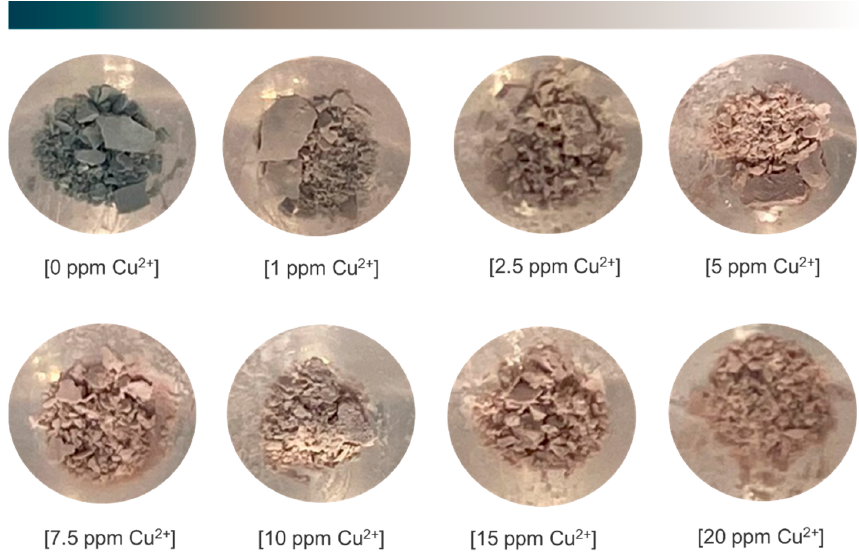
Figure 4. Colourimetric alterations of Cy1 -doped MNs after Cu 2+ exposure.